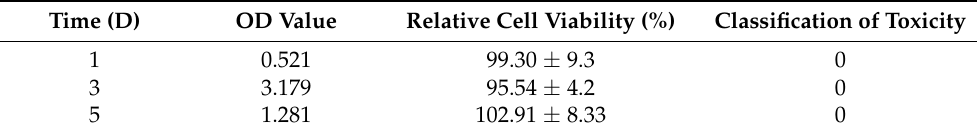
Table 2. Classification of OD relative cell viability and toxicity of SCSC at different days of culture. Time (D) OD Value Relative Cell Viability (%) Classification of Toxicity 0.521